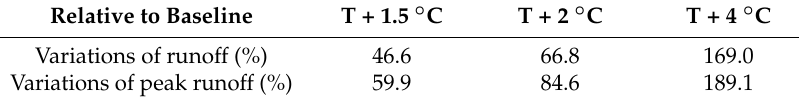
Table 5. Runoff variation under different temperature variation scenarios.